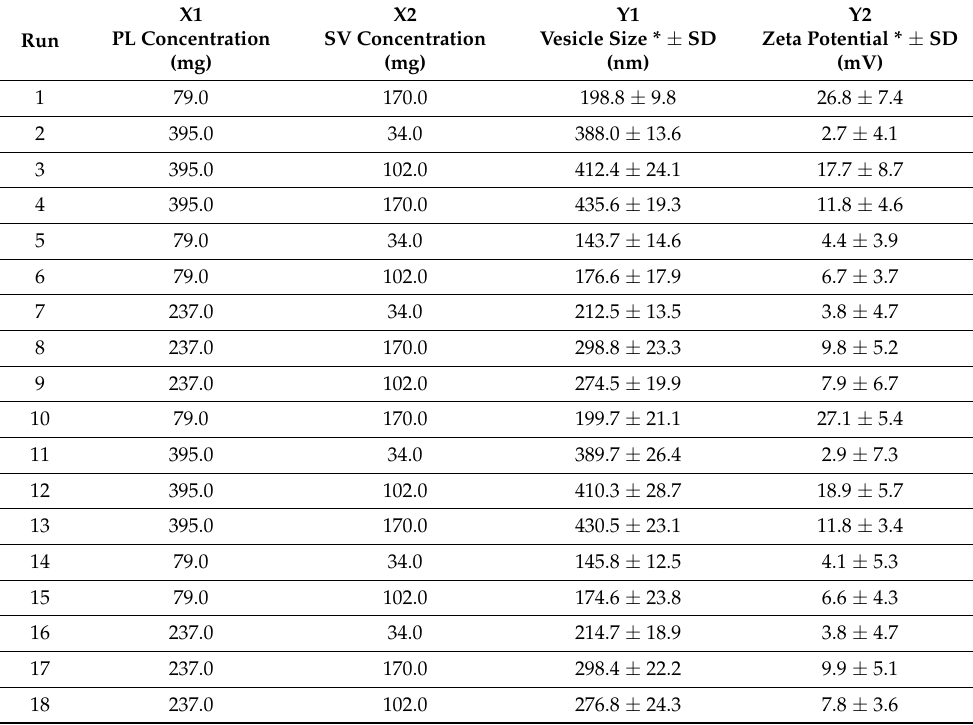
Table 2. Combination of independent variables in THQ–PL–SV phytosomes experimental runs, prepared according to 3 2 factorial design, and their corresponding